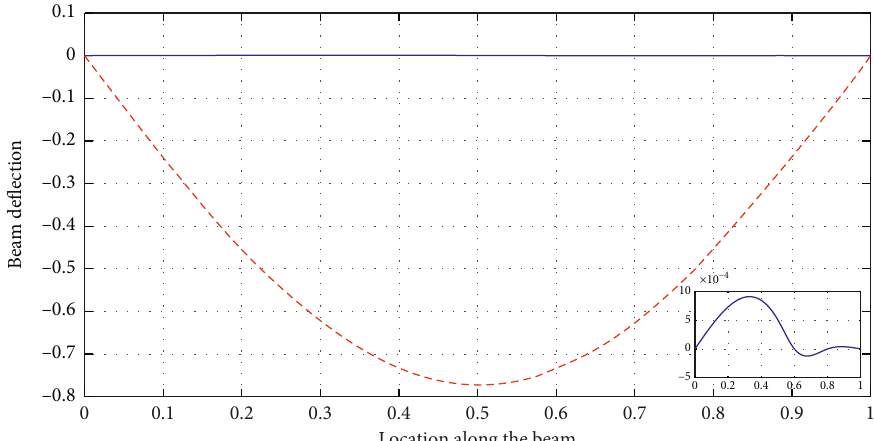
Figure 13: The steady-state deformed shape of a noncollocated controlled (solid line) and uncontrolled (dashed line) undamped simply supported beam when ω � 10, x f � 0.5, x the controlled shape.